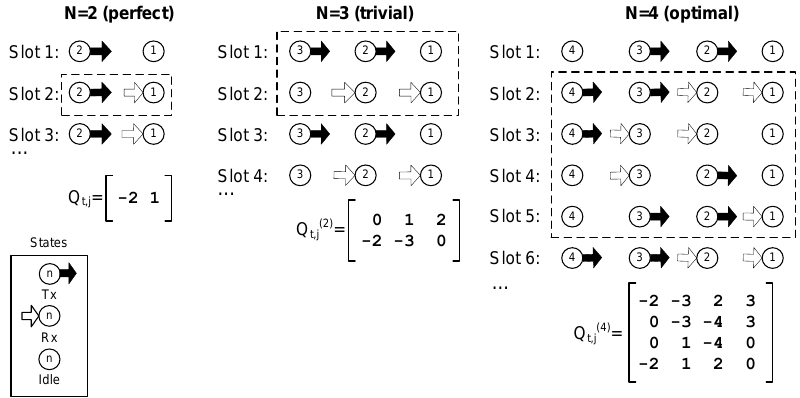
Figure 4. Examples of efficient schedules for different network sizes ( 𝑁 ). Matrix 𝑄 (𝑇) is provided for each case, and the first frame is highlighted in a dashed line. The perfect schedule is only possible for 𝑁 = 2 , with period 𝑇 = 1 . If 𝑁 = 3 , the solution is trivial, with period 𝑇 = 2 . For 𝑁 = 4 , the optimal solution is shown ( 𝑇 = 4 ).